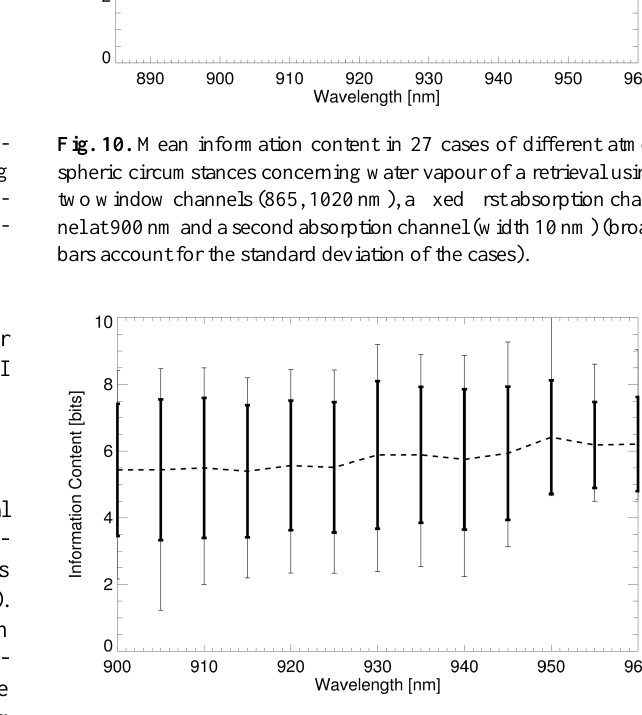
Fig. 11. Mean information content in 27 cases of different atmo- spheric circumstances concerning water vapour of a retrieval using two window channels (865, 1020 nm), a fixed first absorption chan- nel at 915 nm and a second absorption channel (width 10 nm) [broad bars account for the standard deviation of the cases].